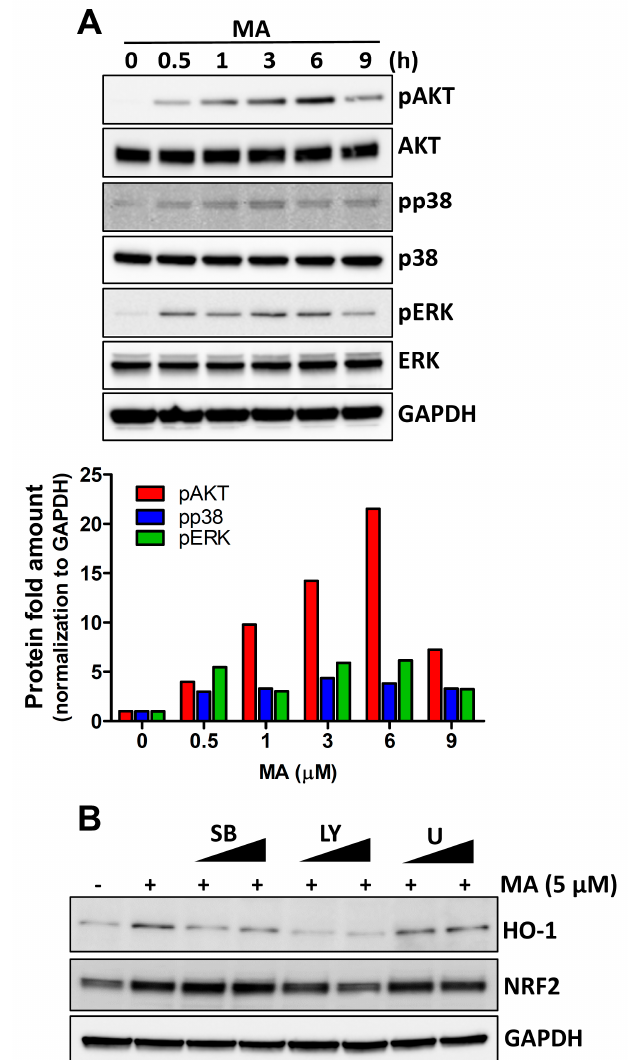
Figure 3. MA increases the NRF2 activity through p38 and AKT signaling in HeLa cells. ( A ) The Western blotting assay shows the activation of AKT, p38, and ERK by MA in different periods. Densitometric analysis of phosphorylated proteins is shown below (A). ( B ) Western blotting data shows the HO-1 and NRF2 levels after treatment with different inhibitors (5 µM and 10 µM) in the SB, a p38 inhibitor SB203580; LY, an AKT inhibitor LY294002; U, a MEK1 / 2 presence of MA for 4h. SB, a p38 inhibitor SB203580; LY, an AKT inhibitor LY294002; U, a MEK1/2 inhibitor.